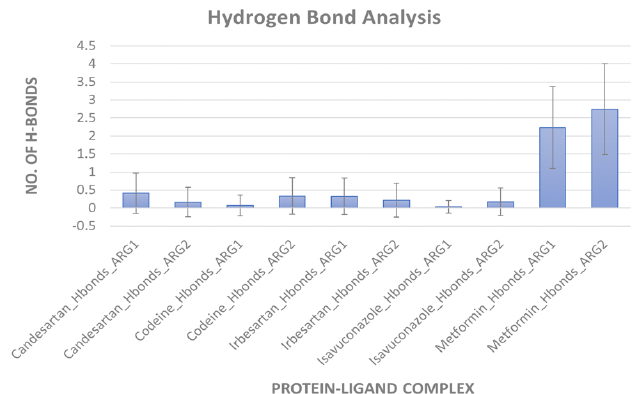
Figure 5. Hydrogen bond formation during MD simulation. An average number of hydrogen bonds between arginases and ligand during 50 ns simulation (Set A). Error bars indicate standard deviation.